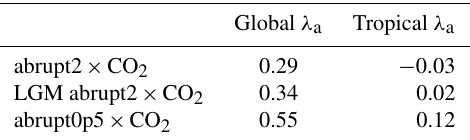
Table 4. Global and tropical (30 ◦ S–30 ◦ N) surface albedo feed- back ( λ a ) values computed with the PRP method for three simula- tions performed with